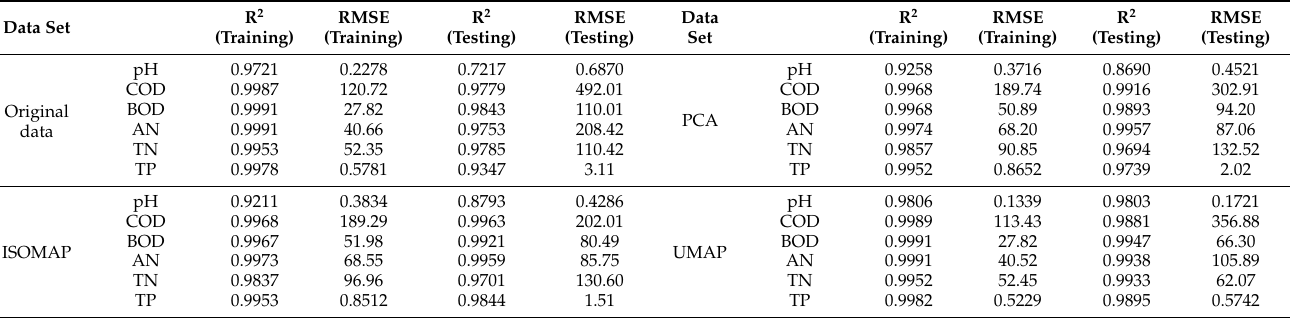
Table 5. Comparison of the LightGBM prediction models based on different manifold learning methods.